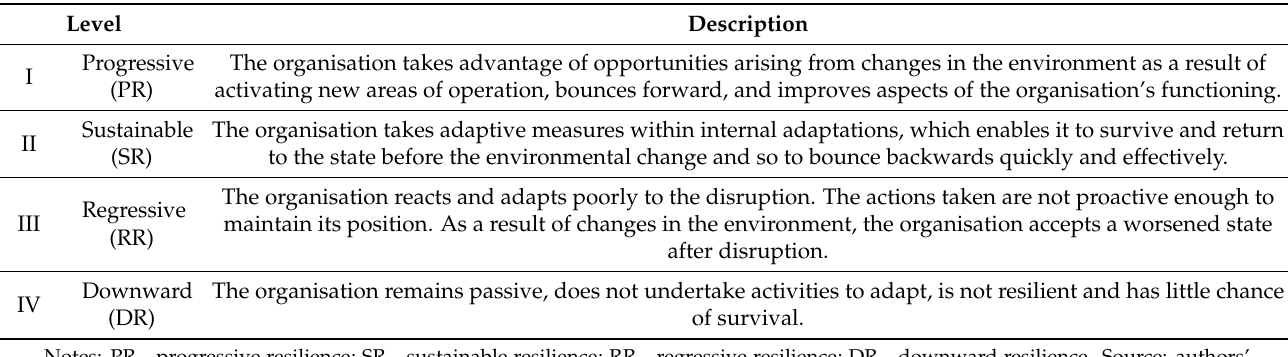
Table 2. Descriptive levels of organisational resilience (OR).